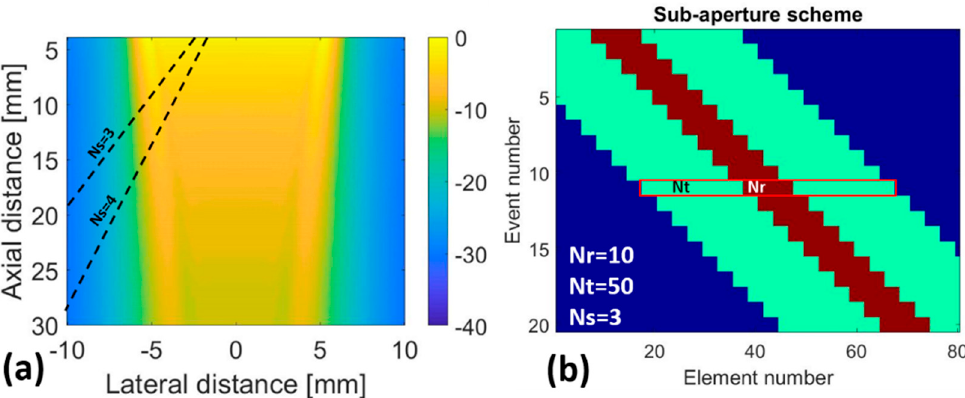
Table 1. The variables used in the numerical study.